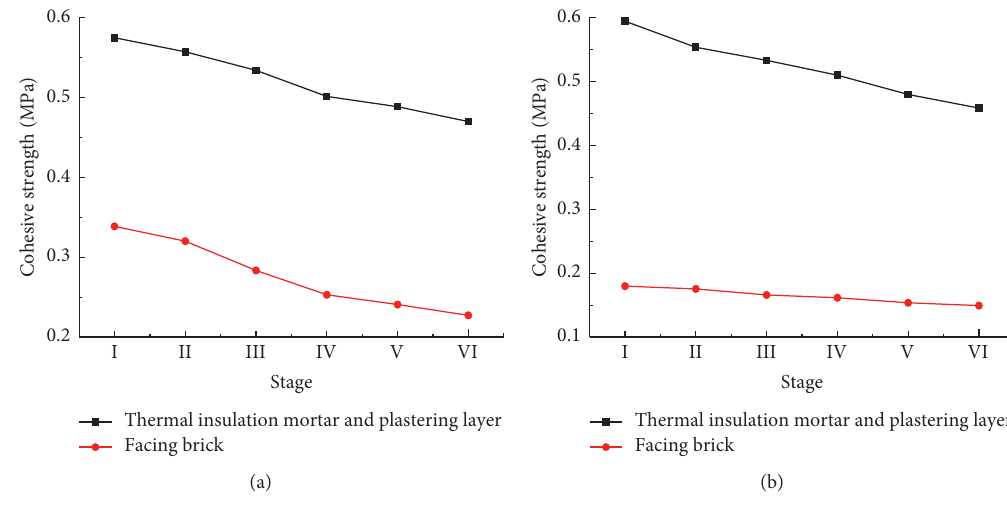
Figure 23: Bond strength curve. (a) Glazed bead thermal insulation mortar finish layer. (b) Modified polystyrene board finish layer. Table 8: Appearance and structure inspection index of the building finish layer.